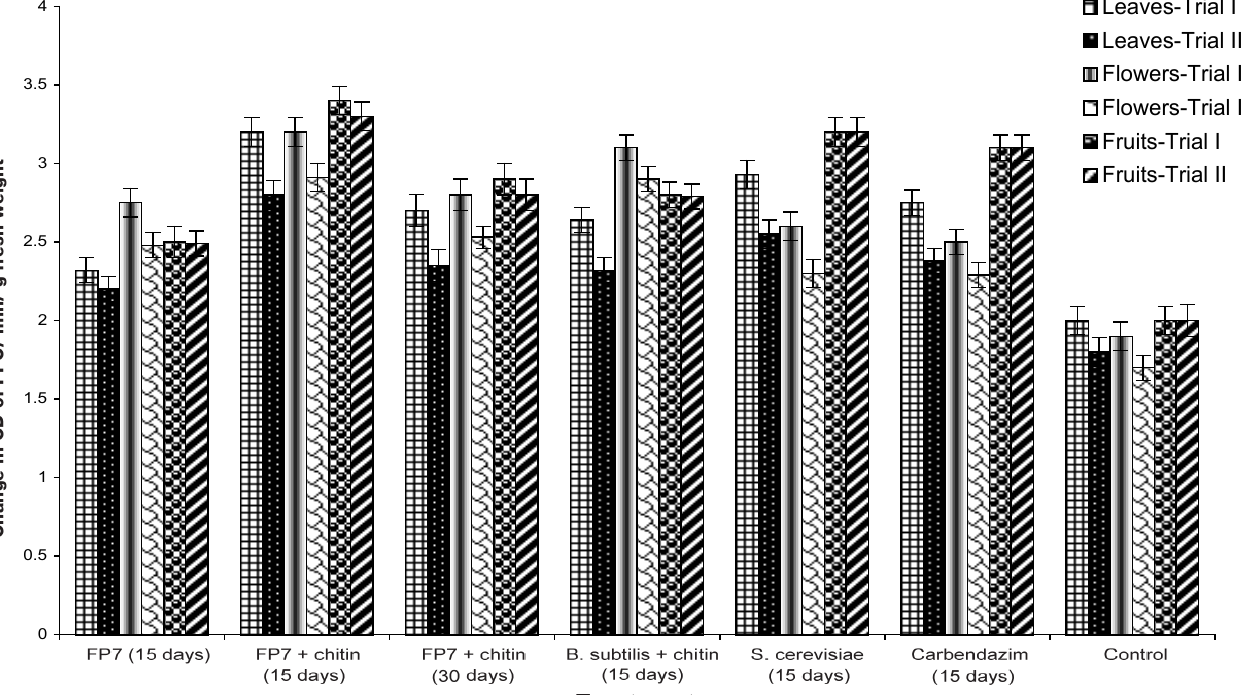
Fig. 7. Effect of pre-harvest application of biocontrol formulations on induction of PPO in mango trees.